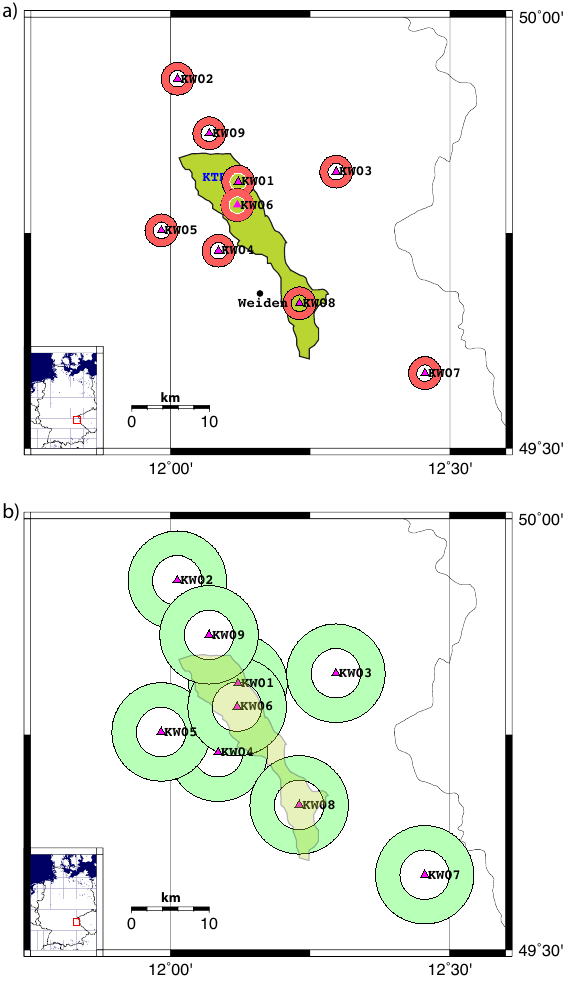
Figure 6. Map of the study area, with station location, the location of the metamorphic Erbendorf body at surface (green), and the areal coverage of teleseismic rays projected at surface for 10km (a) and 30km (b) , considering epicentral distances of the incoming rays between 30 an